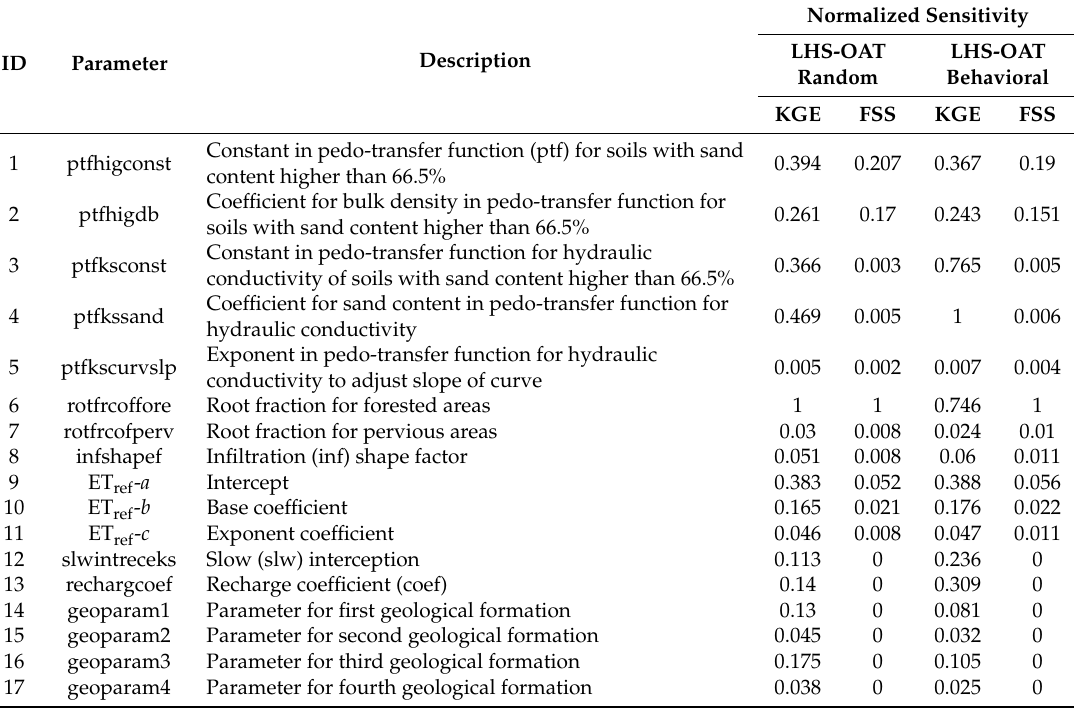
Table A1. Comparison of sensitive parameters using different